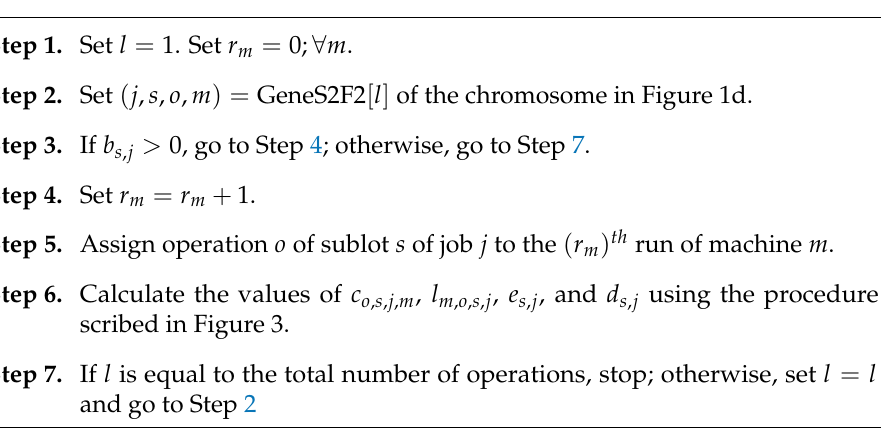
Figure 4. A decoding procedure for the solution representation given in Figure 1d for the second stage of the two-stage genetic algorithm. Table 3. Calculating the objective function terms once the values of c o , s , j , e s , j , d s , j , and l m , o , s , j are evaluated corresponding to each sublot with non-zero